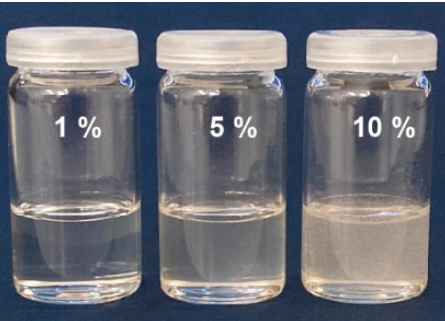
Figure 3. Photograph shows the appearance of different percentages of silk fibroin dissolved in ZnCl 2 (56% w / w ) after 1 h at 45 °C.